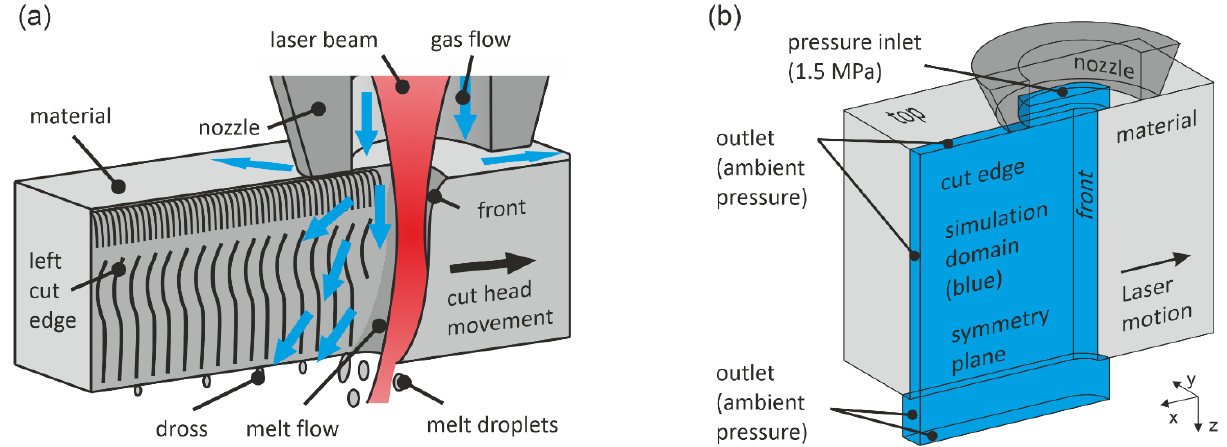
Figure 1. ( a ) Scheme of laser fusion cutting; ( b ) Geometric model and applied boundary conditions, simulation domain for the gas flow highlighted in blue.